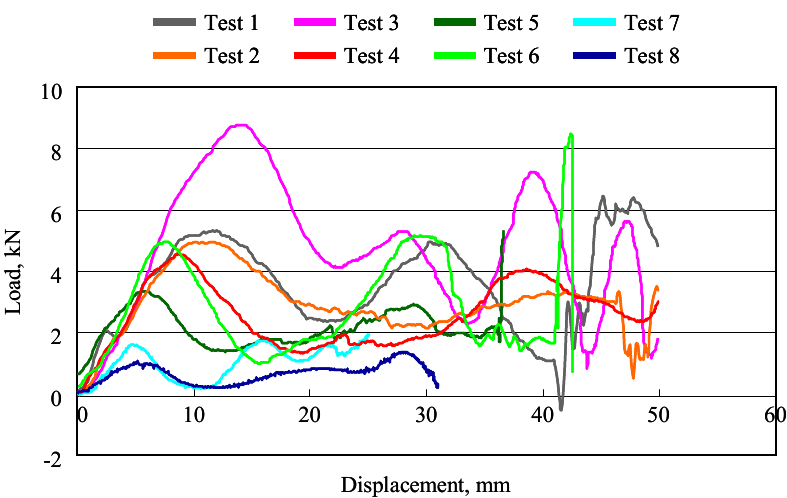
Fig. 7 Load-displacement curves obtained from drop impact